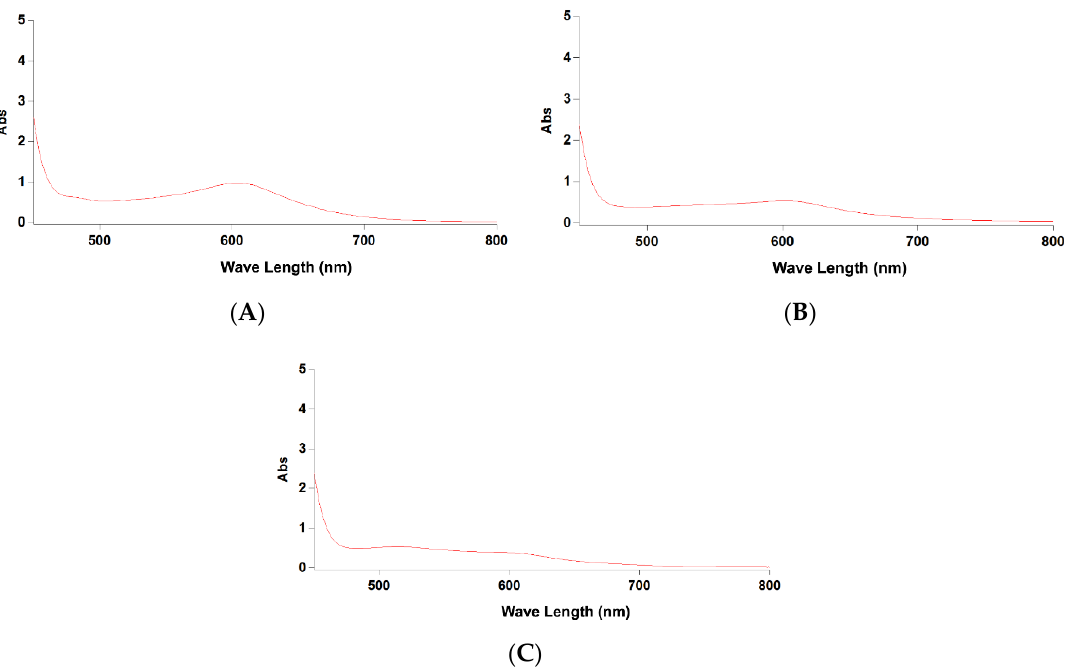
Figure 3. UV-Vis spectra of reaction mixture from vanillin-sulfuric acid assay between 450 nm and 800 nm. ( A ) Theasaponin E 1 (1.0 mg/mL). ( B ) Total saponin fraction of C. sinensis seeds (1.0 mg/mL). ( C ) Crude extract of C. sinensis seeds (1.0 mg/mL).